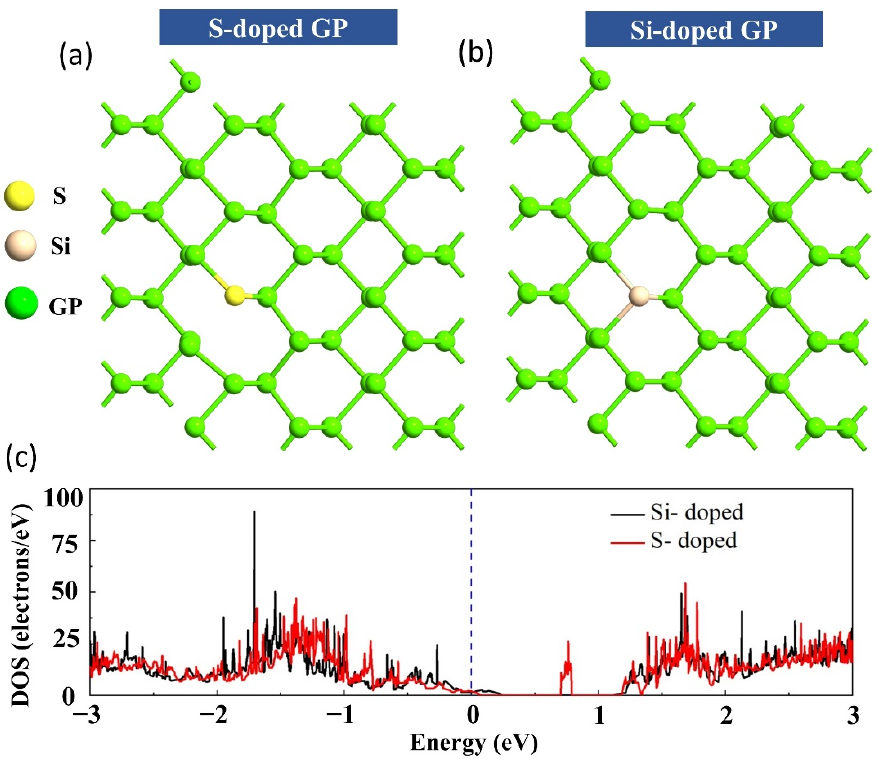
Figure 2. The relaxed atomic structures of ( a ) S-doped and ( b ) Si-doped GP sheet, along with DOS calculations. ( c ) DOS